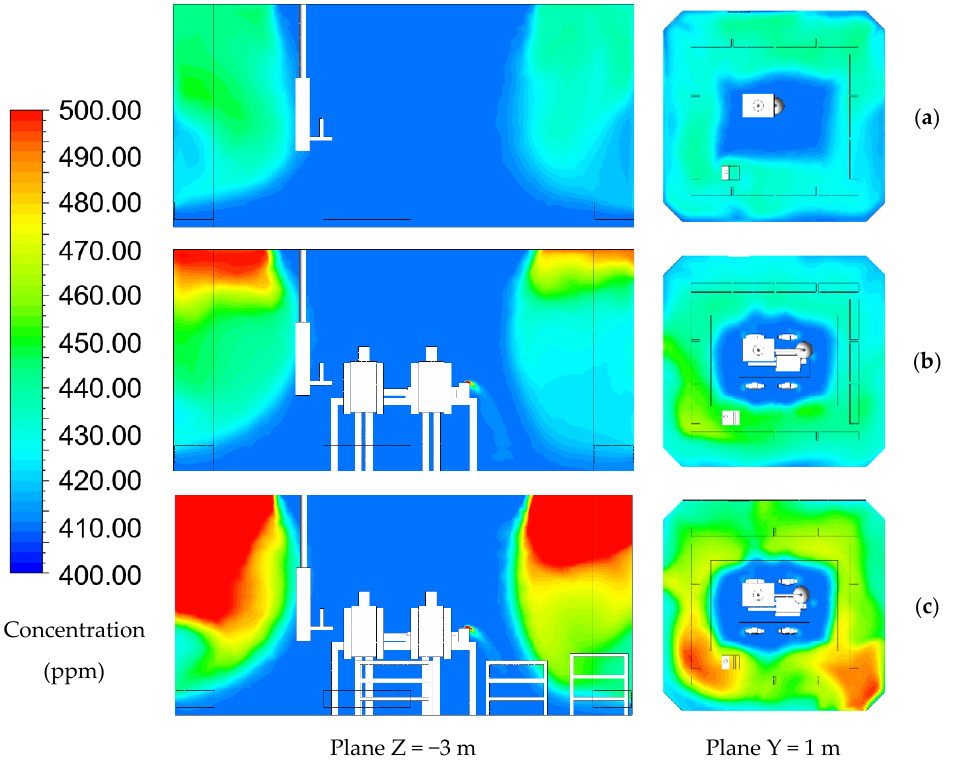
Figure 7. The concentration profile in different schemes: ( a ) case 1: at-rest condition; ( b ) case 2: operational condition; ( c ) case 3: actual condition.